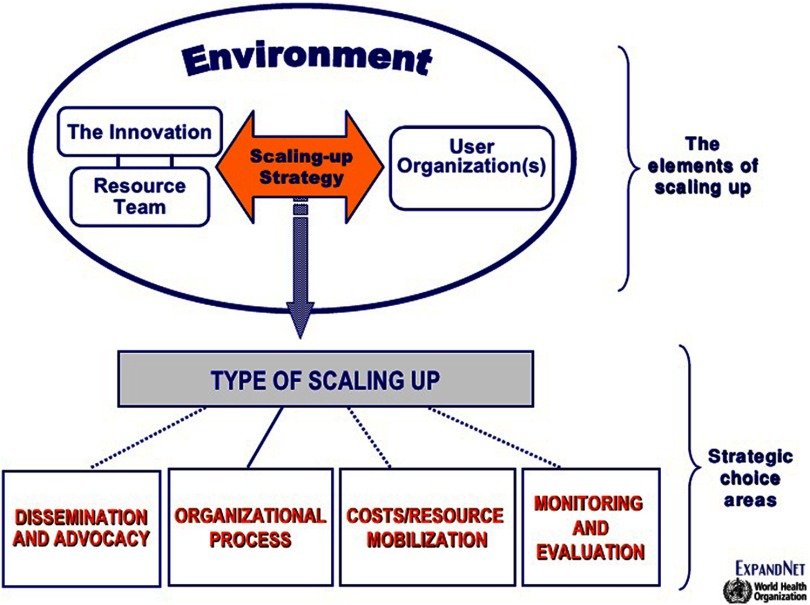
ExpandNet/World Health Organization Scale-Up Framework